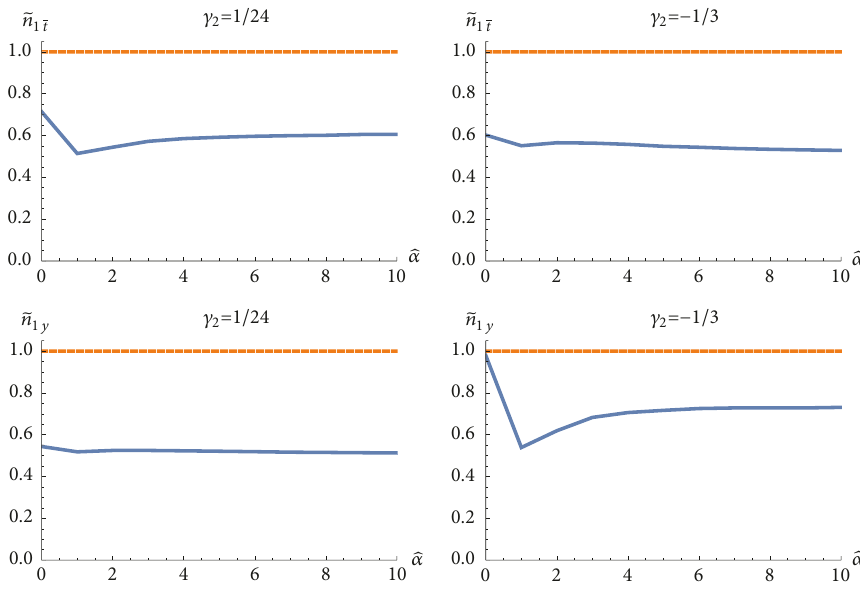
Figure 17: Both ̃𝑛 1𝑡 and ̃𝑛 1𝑦 as the function ̂𝛼 for sample 𝛾 2